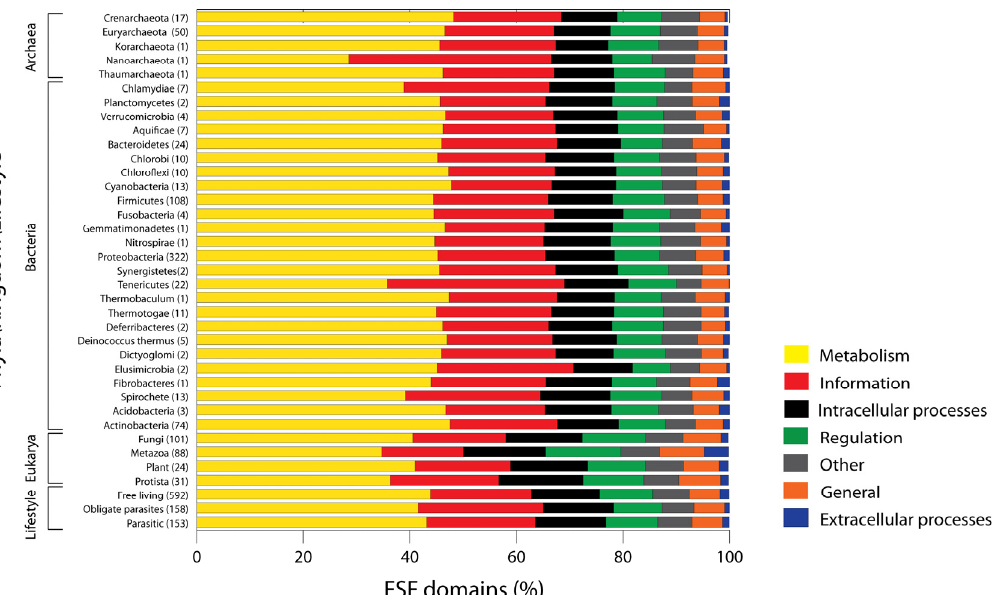
Figure S1. Average distribution of FSFs in phyla, kingdom, and superkingdoms suggest conservation of functional design in proteomes. Numbers in parentheses indicate total number of proteomes analyzed for each